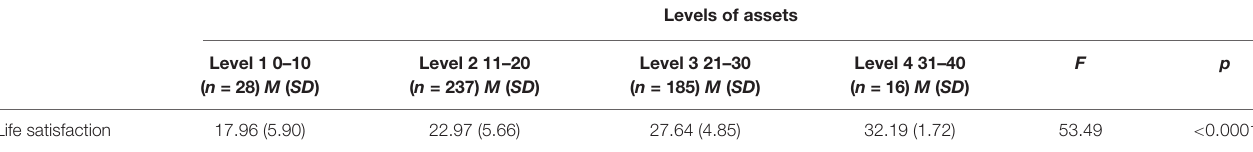
TABLE 4 | Means (standard deviations in parenthesis) for scores on the satisfaction with life scale by levels of assets.